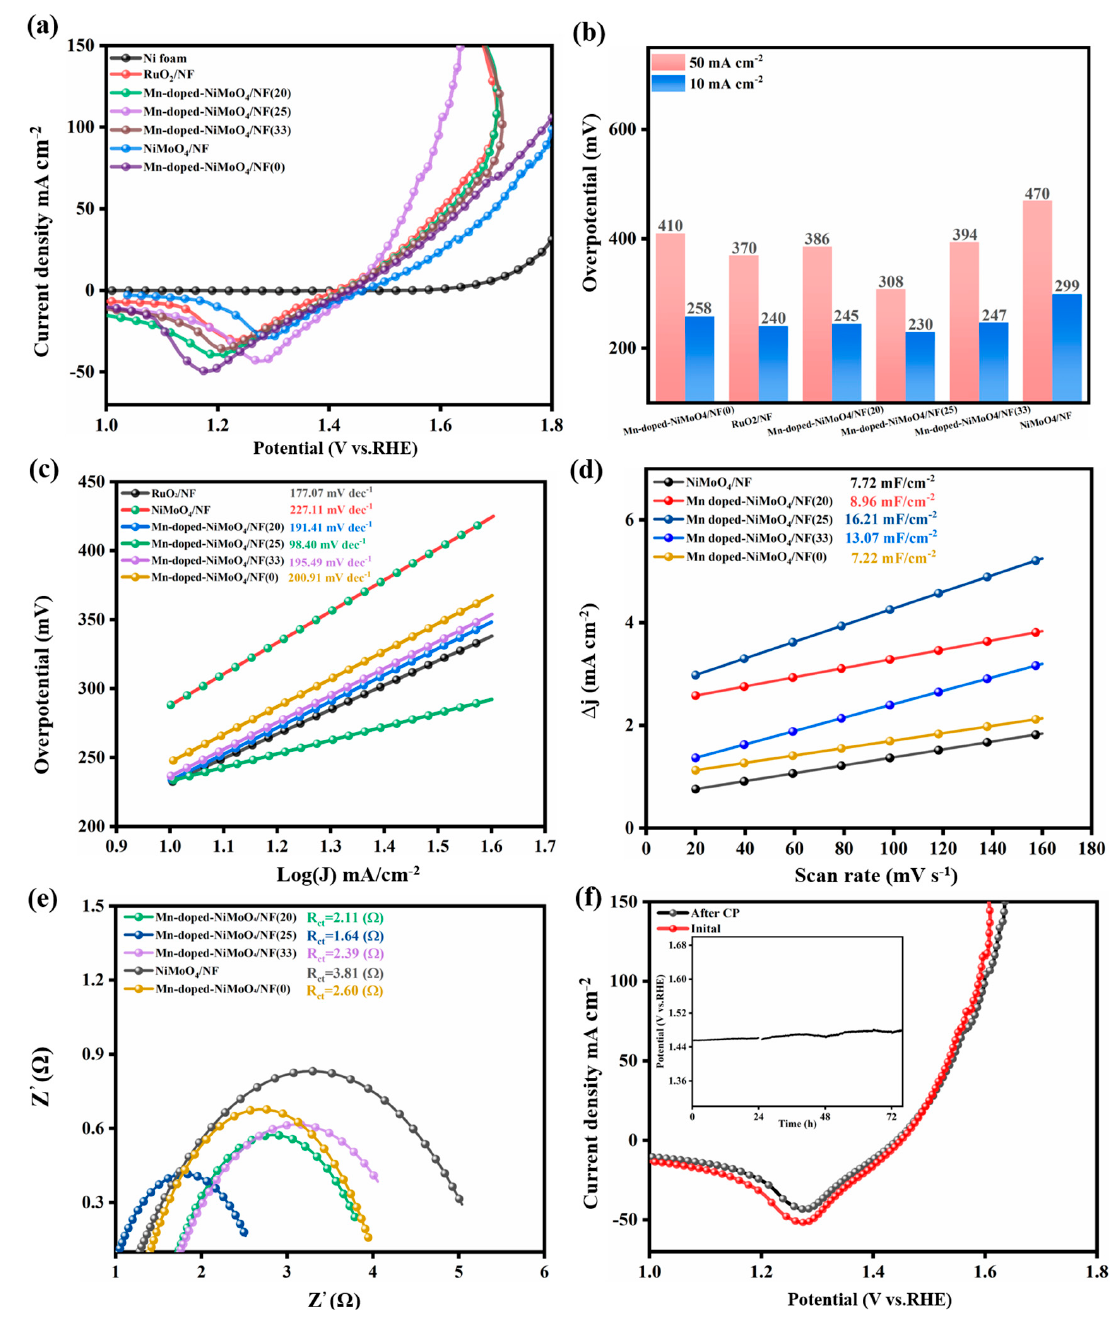
Figure 7. OER performance of the electrocatalyst samples. ( a ) LSV polarization curve. ( b ) Histogram of overpotentials for samples at 20 and 50 mA cm − 2 . ( c ) Tafel slope diagram. ( d ) The double-layer capacitance was obtained at different scan rates (20–160 mV s − 1 ). ( e ) The EIS Nyquist plots at an open circuit voltage of 380 mV. ( f ) LSV polarization curves of Mn-doped-NiMoO 4 /NF (25) before and after 76 h of chronotropic potential testing at 10 mA cm − 2 .